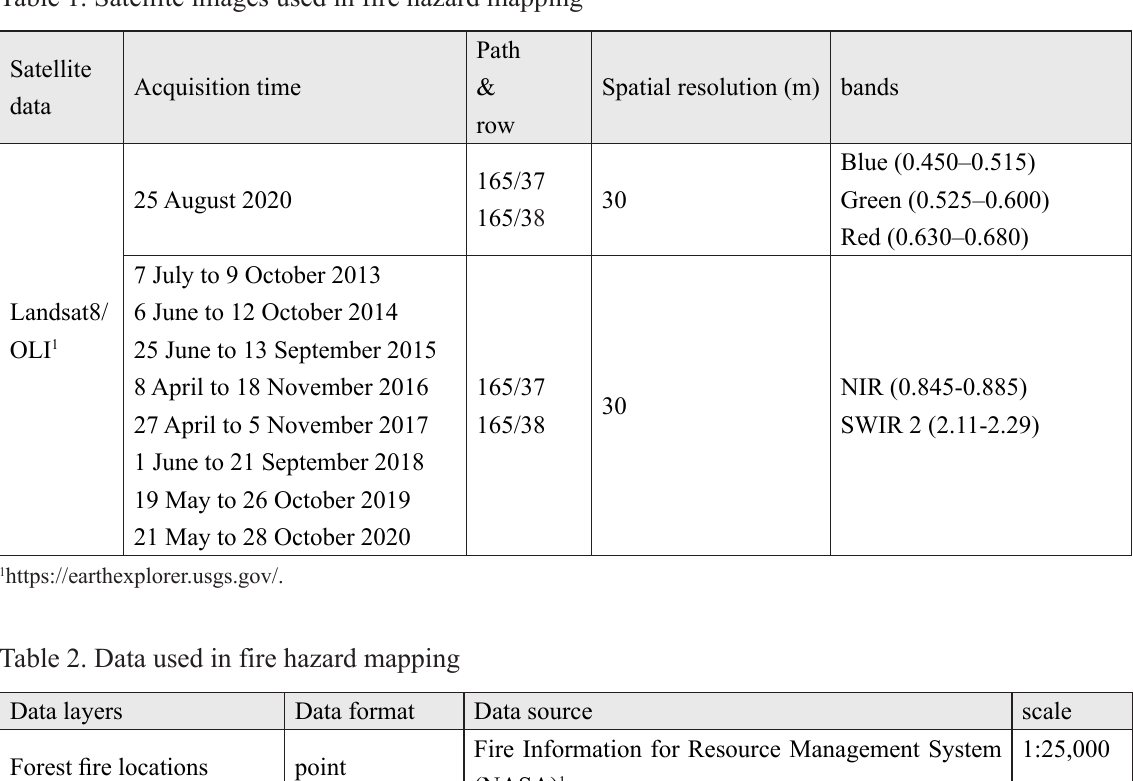
Table 1. Satellite images used in fire hazard mapping